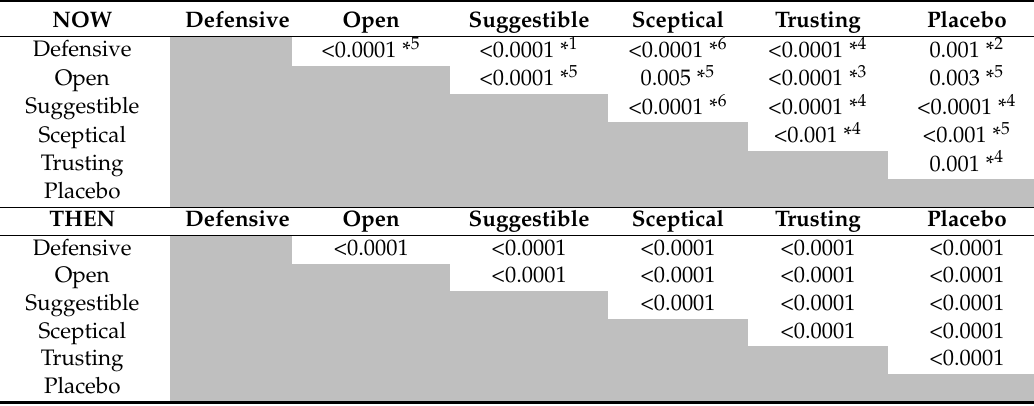
Table A13. Psychological attitudes 2, including placebo responsiveness.